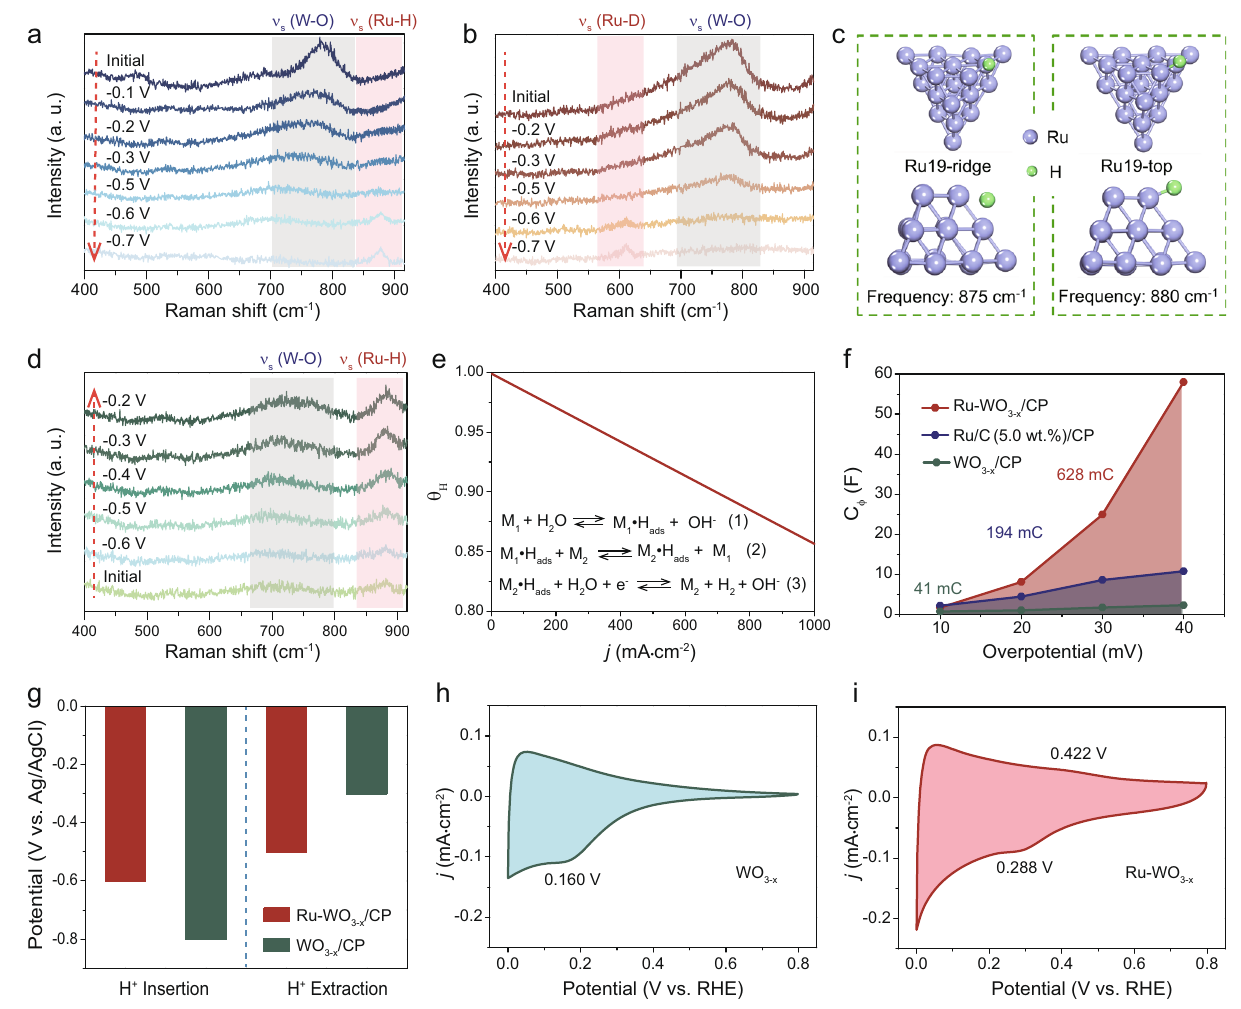
Fig. 4 | Insights of hydrogen spillover. a In situ Raman spectra of Ru-WO 3 − x /CP recorded in 1.0M PBS from − 0.1 to − 0.7V vs. Ag/AgCl. b In situ Raman spectra of Ru-WO 3 − x /CPrecordedfrom − 0.2to − 0.7Vvs.Ag/AgClin1.0MPBS(inD 2 O). c Side and top view illustrations of DFT models used for Raman frequency calculation of Ru-Hvibration. d InsituRamanspectraofRu-WO 3 − x /CPrecordedin1.0MPBSfrom − 0.6 to − 0.2V vs. Ag/AgCl. e Hydrogen coverage as a function of current density